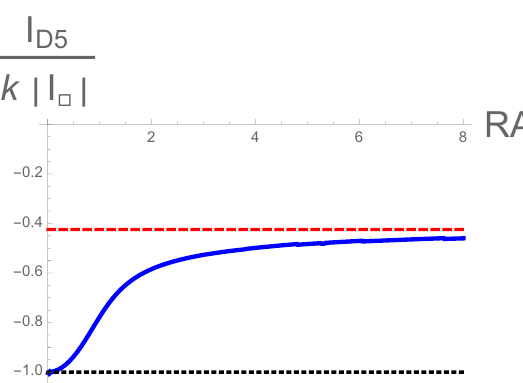
Figure 2 . The free energy (cid:0) ln Z H = I D5 of the non-conformal D5-brane impurity (blue) on H 3 with (cid:12) = 2 (cid:25) , (cid:20) = 0 : 5 as a function of the deformation parameter A . It interpolates between the values of the circular Wilson lines for k coincident quarks (dotted black) in the fundamental representation, and the antisymmetric tensor representation A k (dashed red